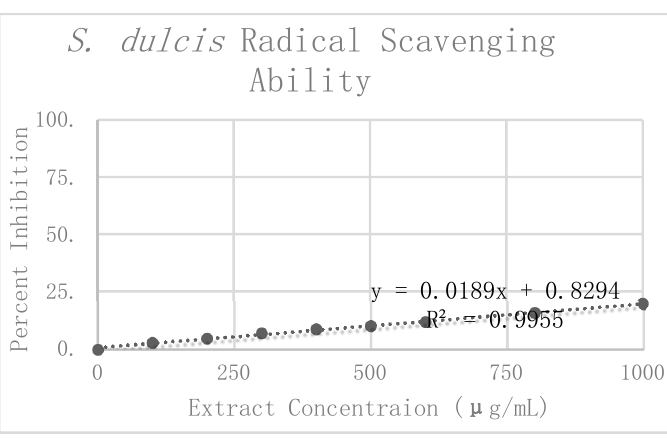
Figure 7. DPPH assay results and radical scavenging effects of S. dulcis .